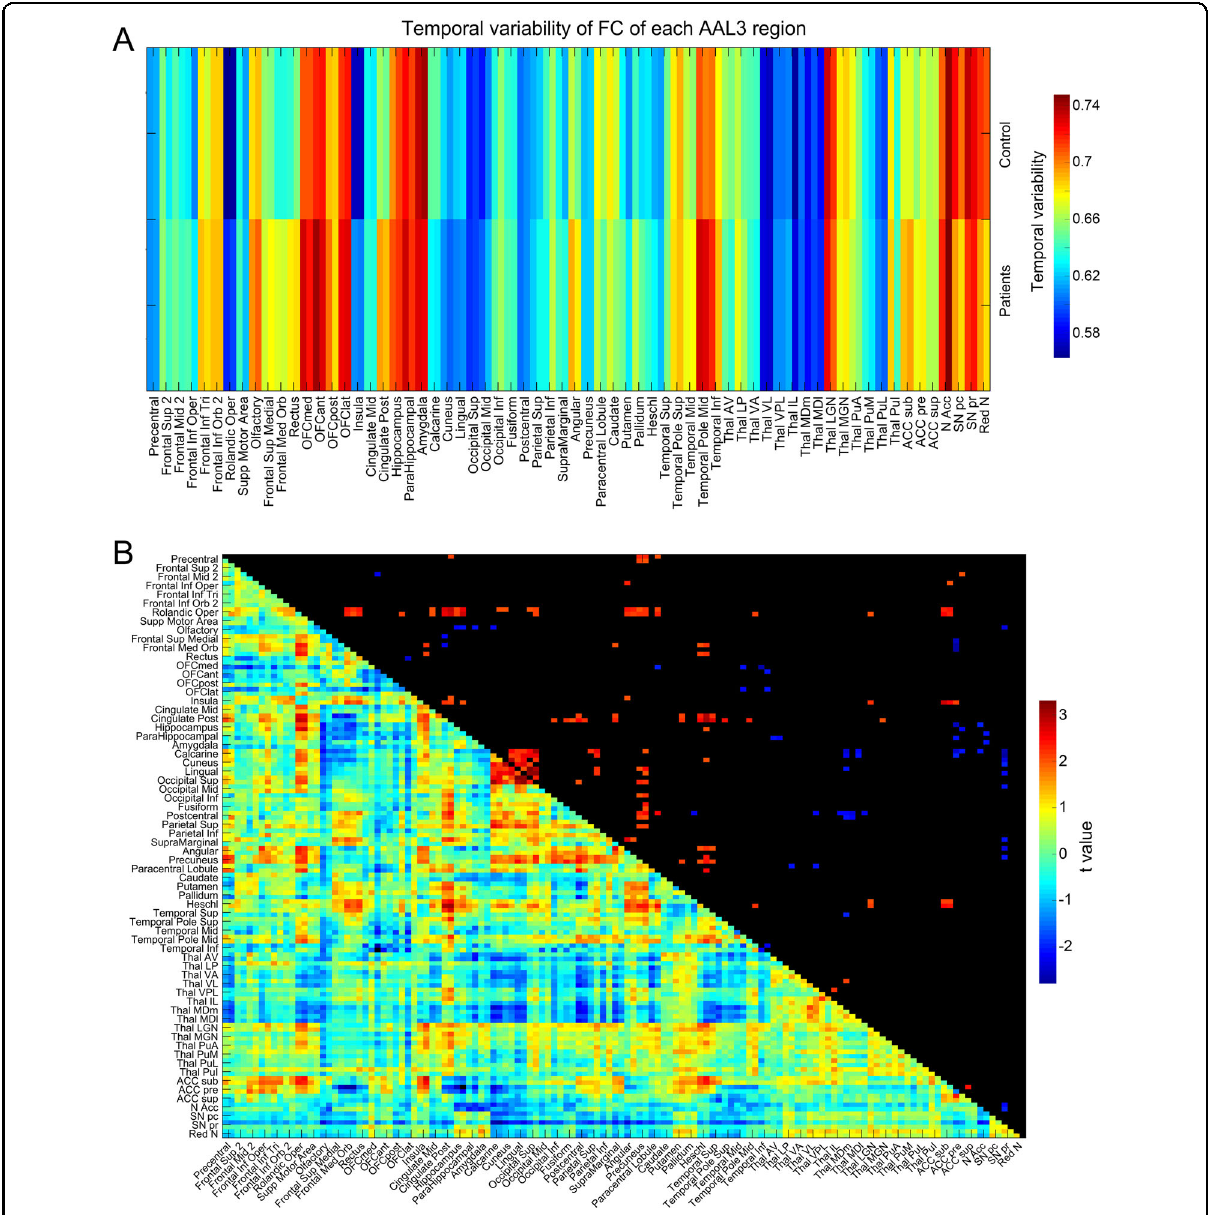
Fig. 4 Lower temporal variability of functional connectivity of some brain regions in ADHD. A The temporal variability of the functional connectivity of different AAL3 regions in the ADHD and control groups. B The functional connectivity of AAL3 areas for the ADHD group minus controls. The lower left shows the t -value for the difference in functional connectivity of patients - controls; the upper right shows the signi fi cantly different functional connectivities with p <0.05, with red showing higher and blue showing lower functional connectivity in patients -